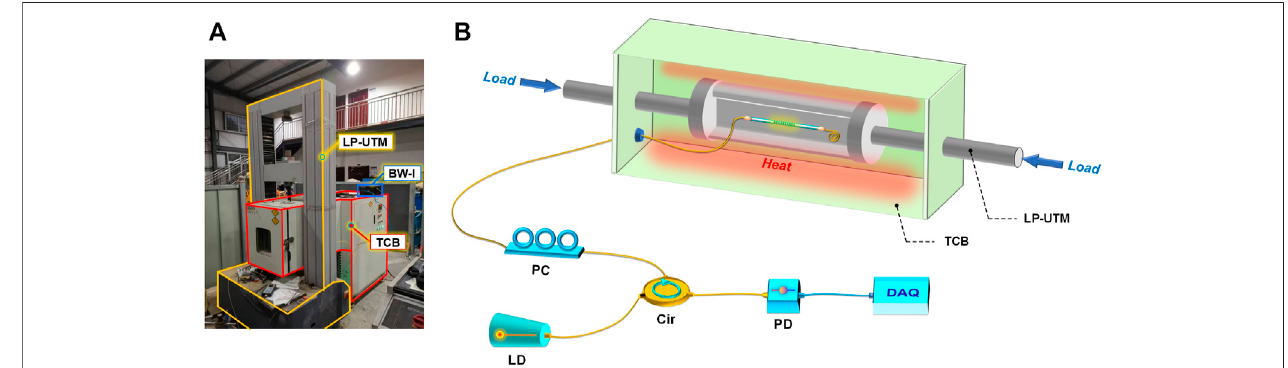
FIGURE 2 | (A) test apparatus and (B) layout of validation experiment. UTM: universal testing machine, TCB: temperature control box, BW-I: Bragg wavelength interrogator,HB-FBG:highbirefringence fi berBragggrating,PC:polarizationcontroller,LD:laserdiode,Cir:circulator,PC:polarizationcontroller,PD:photodiode,DAQ: data acquisition